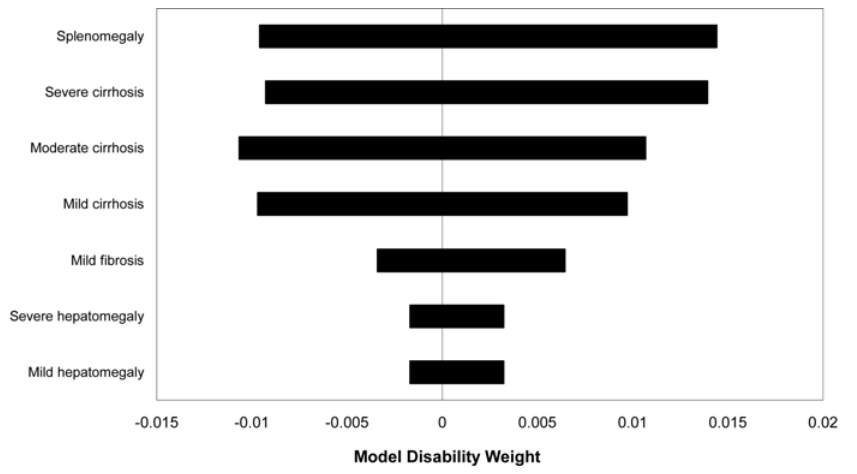
Figure 3. One-way sensitivity analysis. The horizontal bars depict the effect of re-evaluating the disability weight (shown on the X-axis) after changing the value of the specified parameter from the low to the high end of its range. The number of parameters that resulted in the greatest variation are shown.